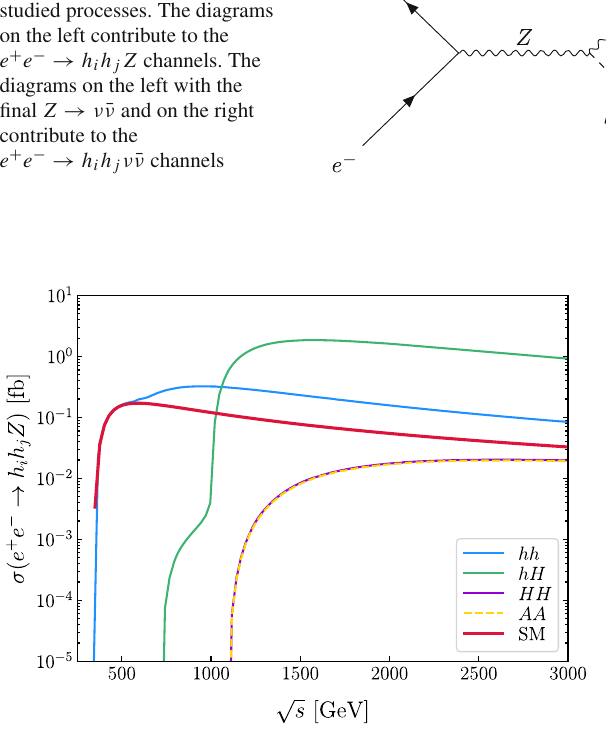
Fig. 1 Diagrams that include triple Higgs couplings in the di-Higgs production in the studied processes. The diagrams on the left contribute to the e + e − → h i h j Z channels. The diagrams on the left with the final Z → ν ¯ ν and on the right contribute to the e + e − → h i h j ν ¯ ν channels